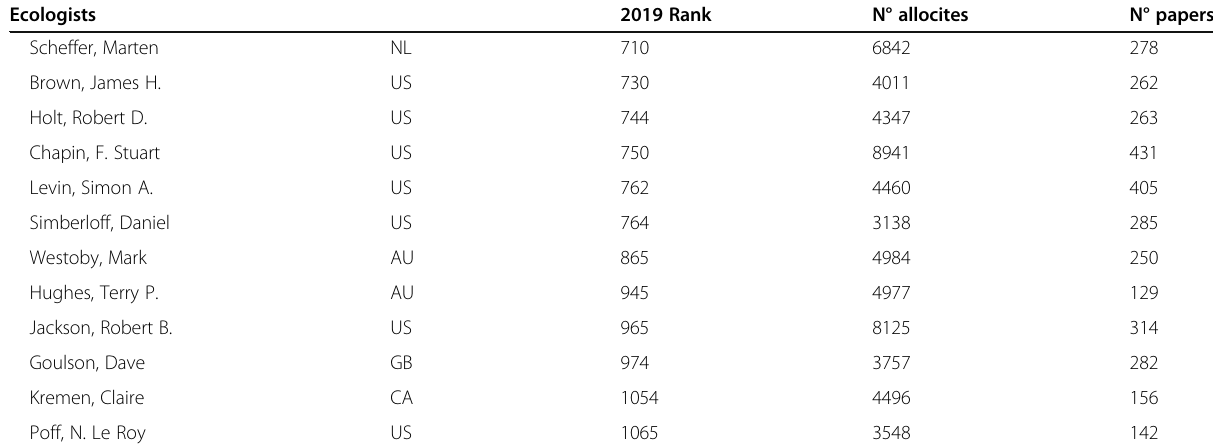
Table 4 Single-year (2019) impact ranking of Latin American ecologists, their No. allocites, and No. papers in the Scopus database (from Table S-7, 2019 Single-year ranking, by Ioannidis et al. [3]). For the global sample, countries are identified by their ISO 3166 Codes (Continued)